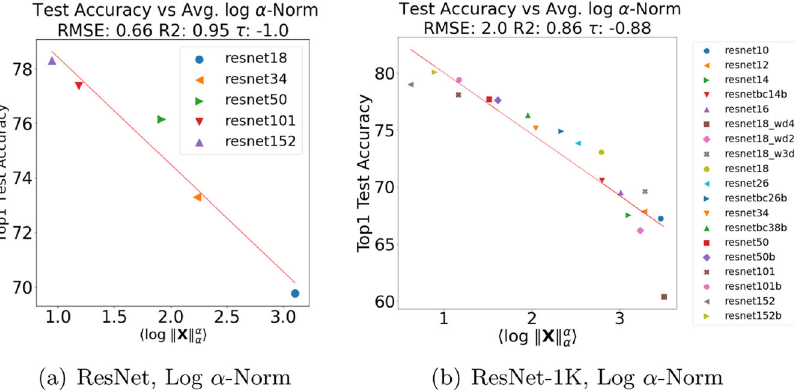
Fig. 3 Comparison of average α -Norm quality metric for CV models. Comparison of average α -Norm quality metric versus reported Top1 test accuracy for the ResNet (in ( a )) and ResNet-1K (in ( b )) pretrained (pyTorch) models. Metrics fi t by linear regression, RMSE, R2, and the Kendal-tau rank correlation metric